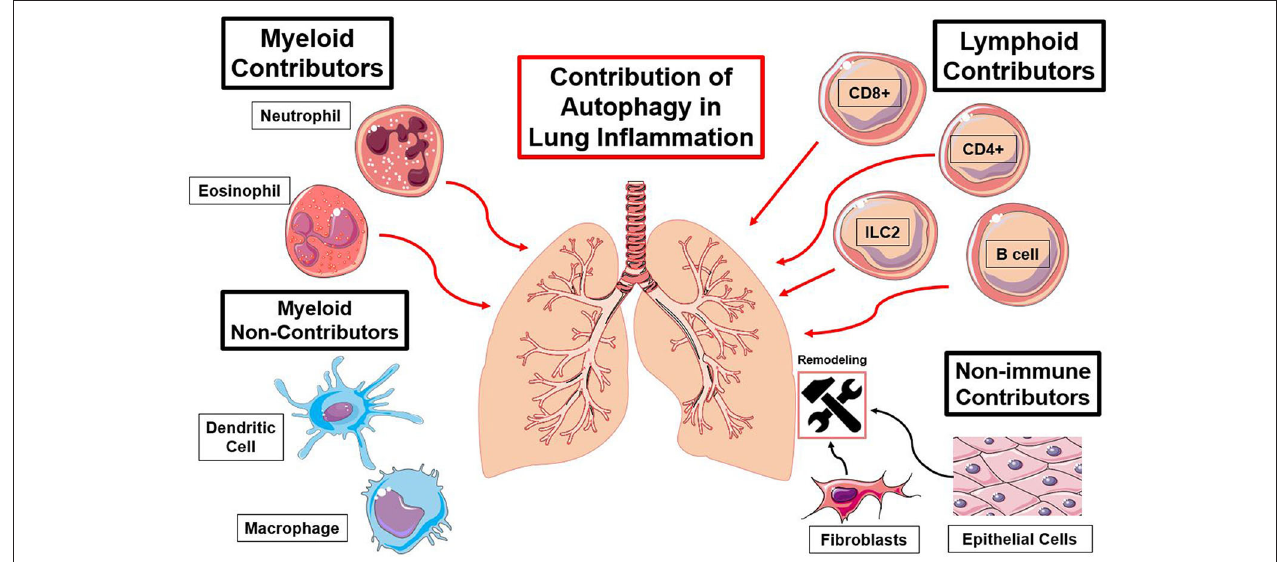
FIGURE 3 | Summary of immune cell types and the functions of autophagy contributing to lung inflammation. Red lines indicate an autophagy-mediated increase in inflammation and black lines indicate an autophagy-mediated contribution to lung remodeling [(23, 25, 27, 30, 37, 41, 57–59, 63, 66, 74, 79, 89, 96, 97, 110, 127), (116, 122, 123, 137, 140,